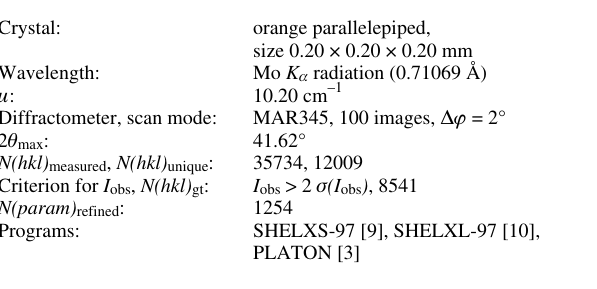
Table 1. Data collection and